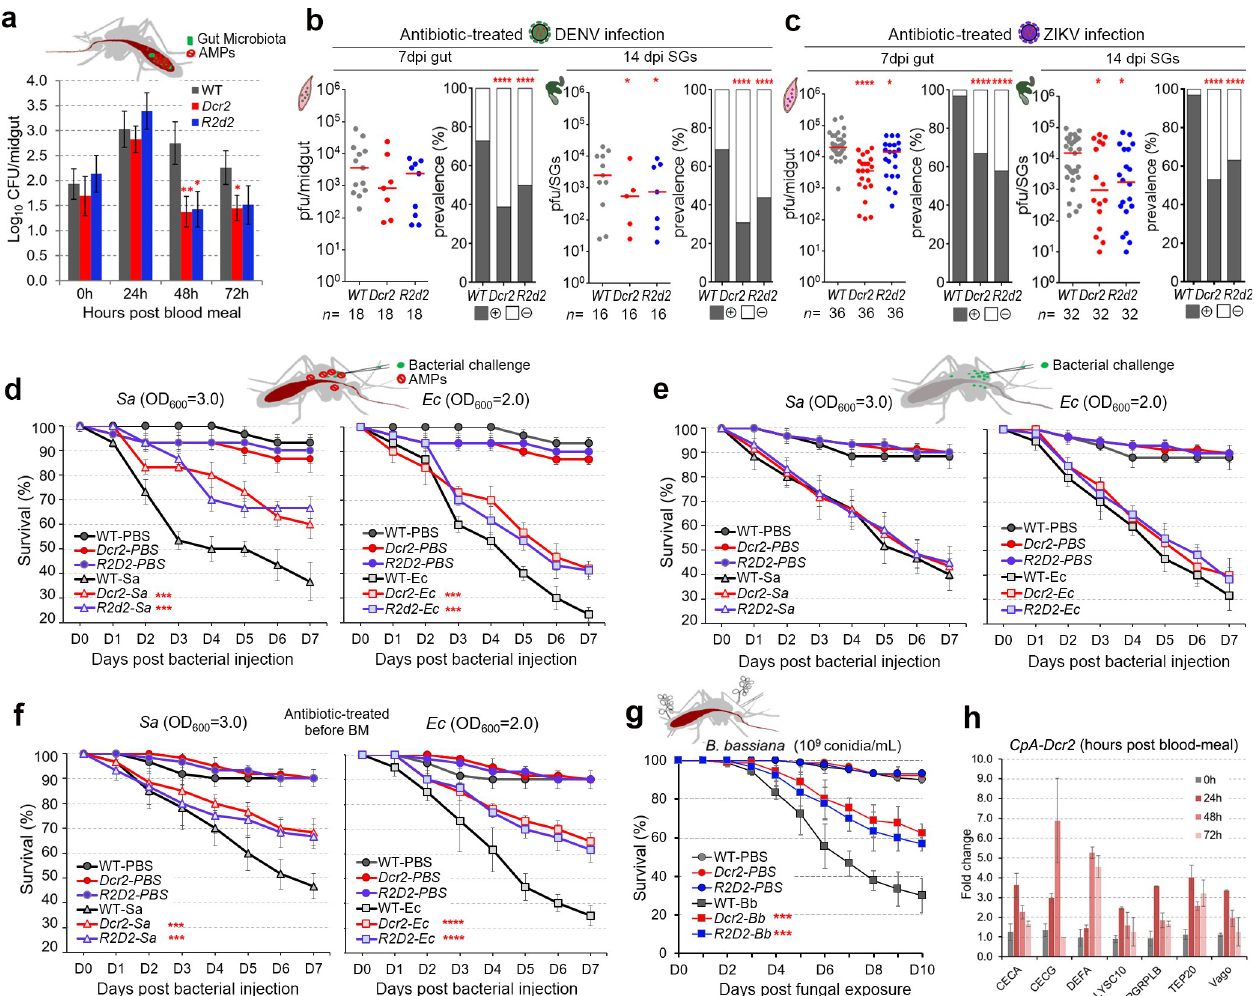
Fig 4. Antimicrobial resistance of siRNA pathway ( Dcr2 and R2d2 ) overexpressing transgenic mosquitoes ( Dcr2 : CpA-Dcr2 , R2d2 : CpA-R2d2 ). The up- regulation of Dcr2 and R2d2 in the transgenic mosquitoes activates the expression of several AMPs and then modulates the Aedes mosquitoes’ susceptibility to bacterial and fungal infection. ( a ) The total bacterial loads of the midgut microbiota of female transgenic and WT control mosquitoes at 24, 48, and 72 h PBM (mean ± SEM). A Student t test was used to determine significance. At least 3 biologicals were included with 10 mosquitoes in each replicate. ( b and c ) DENV2 (b) and ZIKV (c) viral infection intensities and infection prevalence in the aseptic (antibiotic-treated) transgenic and WT mosquitoes at 7 dpi (midguts) and 14 dpi (SGs) showed a similar level of reduction to that in the septic (non-antibiotic-treated) mosquitoes (as shown in Fig 2). At least 3 replicates are included, with each dot representing the viral load and the horizontal line (red) indicating the median value. The Mann–Whitney test was used to assess infection intensity, and the Fisher’s exact test was used to determine the significance of infection prevalence ( � P < 0.05, ���� P < 0.0001). ( d–f ) Survival rate of female transgenic mosquitoes after challenge with either gram-positive ( S . aureus : 210,000 CFU) or gram-negative ( E . coli : 140,000 CFU) bacteria at 7 dpi post a blood meal (d), or without a blood meal (e), or treated with antibiotics for 4 days followed by a blood meal 24 h before bacterial injection (f). ( g ) Survival rates of female WT, transgenic CpA-Dcr2 and CpA-R2d2 mosquitoes after B . bassiana infection. Prior to assays in (a, d, f, and g), all groups of the female mosquitoes were given a na ï ve blood meal to up-regulate the expression of the transgenes. The significance of the survival rates was determined by Kaplan–Meier survival analysis from 3 biological replicates with at least approximately 20 to 30 mosquitoes in each replicate ( ��� P < 0.001, ���� P < 0.0001). ( h ) qRT-PCR expression profiling of a panel of antimicrobial and immune genes (S3 Table) in the midguts of female CpA-Dcr2 transgenic mosquitoes at 0 h (before a blood meal), 24, 48, and 72 h PBM. The WT midguts were used as the control, and the AeRps17 gene was used as an internal control for normalization. Data underlying this figure can be found in S2 Data. AMP, antimicrobial peptide; CFU, colony-forming unit; DENV2, DENV serotype 2; dpi, days post-infection; PBM, post-blood meal; qRT-PCR, quantitative real-time PCR; SG, salivary gland; siRNA, small interfering RNA; WT, wild type; ZIKV, Zika